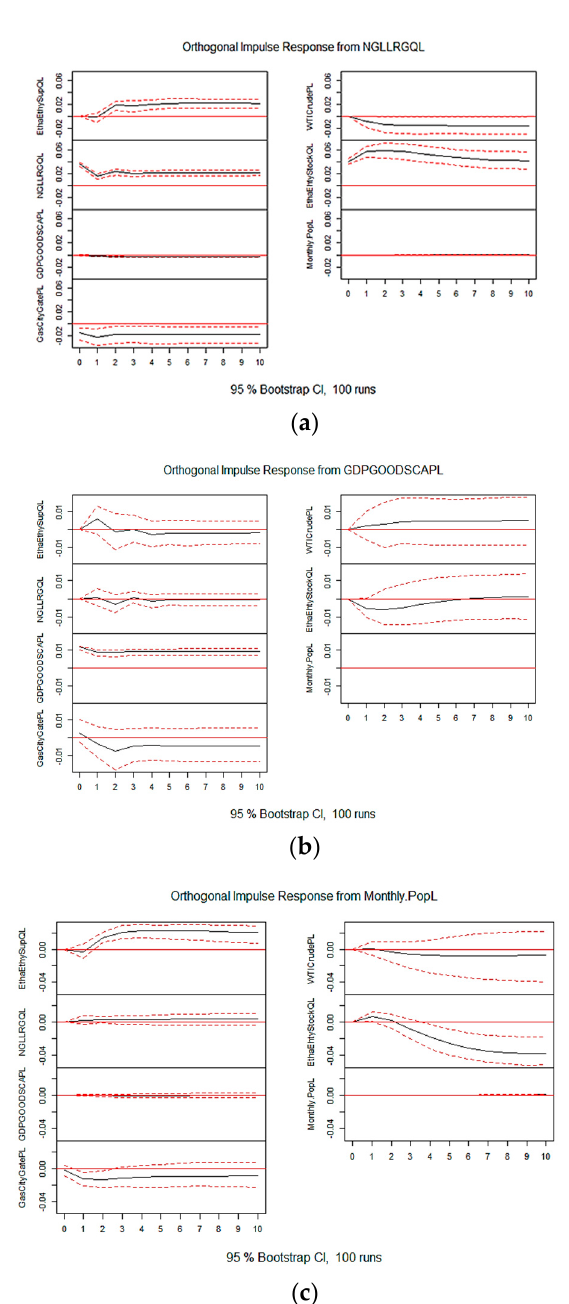
Figure 2. ( a ) OIRF for natural gas liquids, ( b ) OIRF for GDP/PCE, and ( c ) OIRF for population.